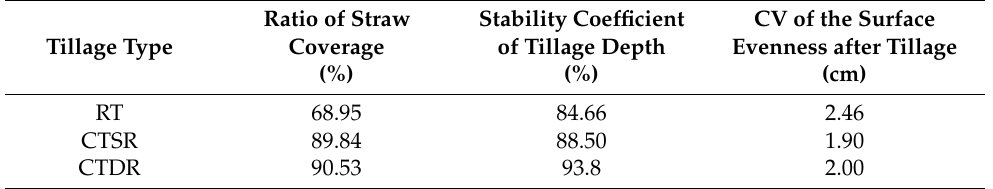
Figure 4. The tillage process of different tillage types: ( a ) Pre-tillage, ( b ) RT, ( c ) CTSR, and ( d ) CTDR. Table 3. Performance indicators of different tillage types in the rice field